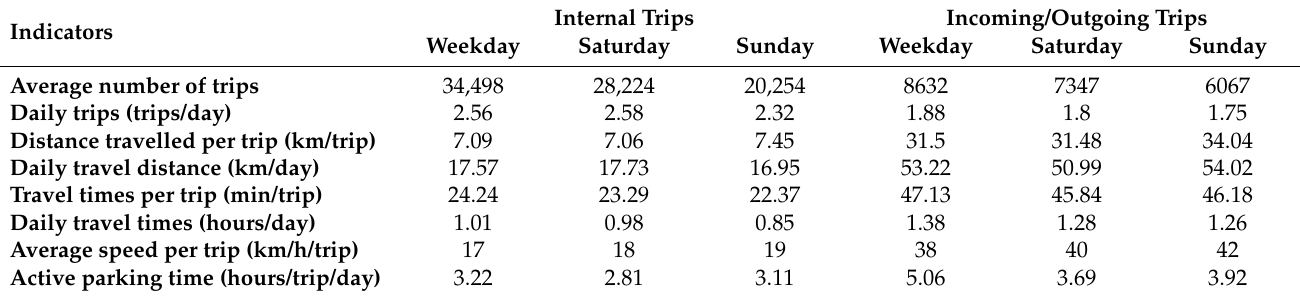
Table 1. Average values of the indicators obtained from FCD of Turin metropolitan